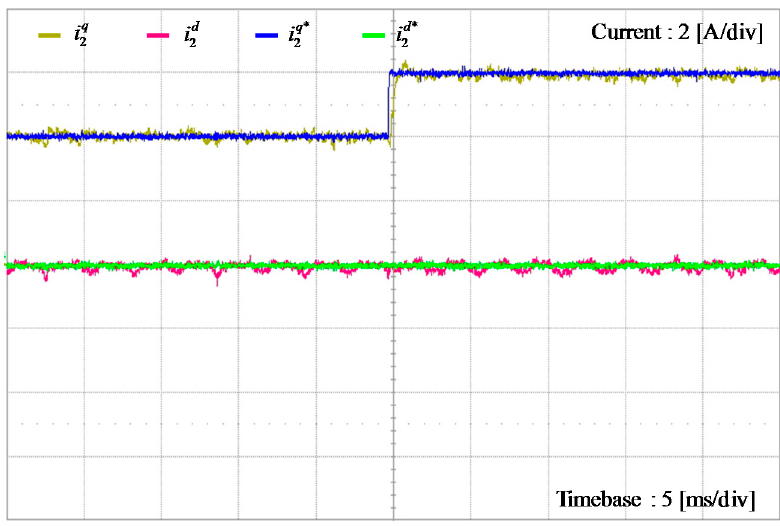
Figure 13. Experimental results of the proposed discrete-time integral state feedback control scheme with state observer under a step change in grid-side q -axis current reference.